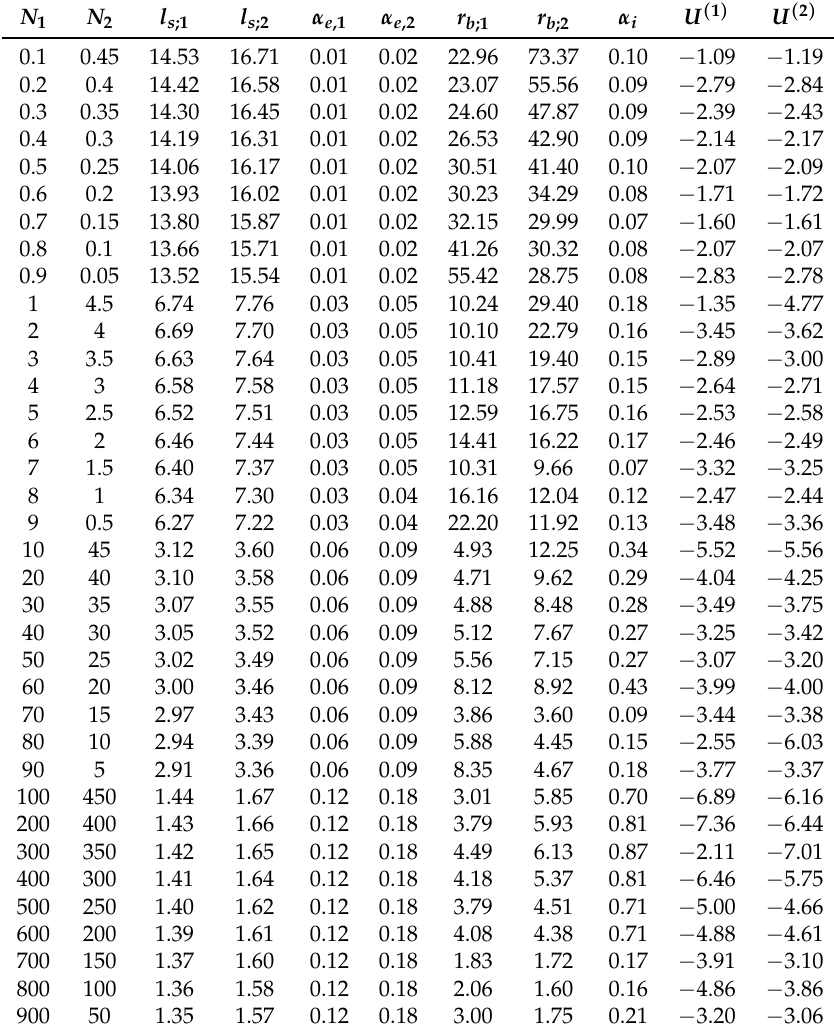
Table 1. The characteristic length l s ;1,2 (in 10 − 7 cm), the non dimensional electron–ion correlation coefficients α e ,1,2 , the main characteristic length r b ;1,2 (in 10 − 7 cm), the non-dimensional ion–ion correlation coefficients α i and the potential energies U ( 1 ) (in eV) and U ( 2 ) (in eV) for the cases of Z 1 = 1 and Z 2 = 2 at T = 3 × 10 4 K in the region of electron densities 10 16 cm − 3 ≤ N e ≤ 10 20 cm − 3 . The densities N 1,2 are in 10 17 cm − 3